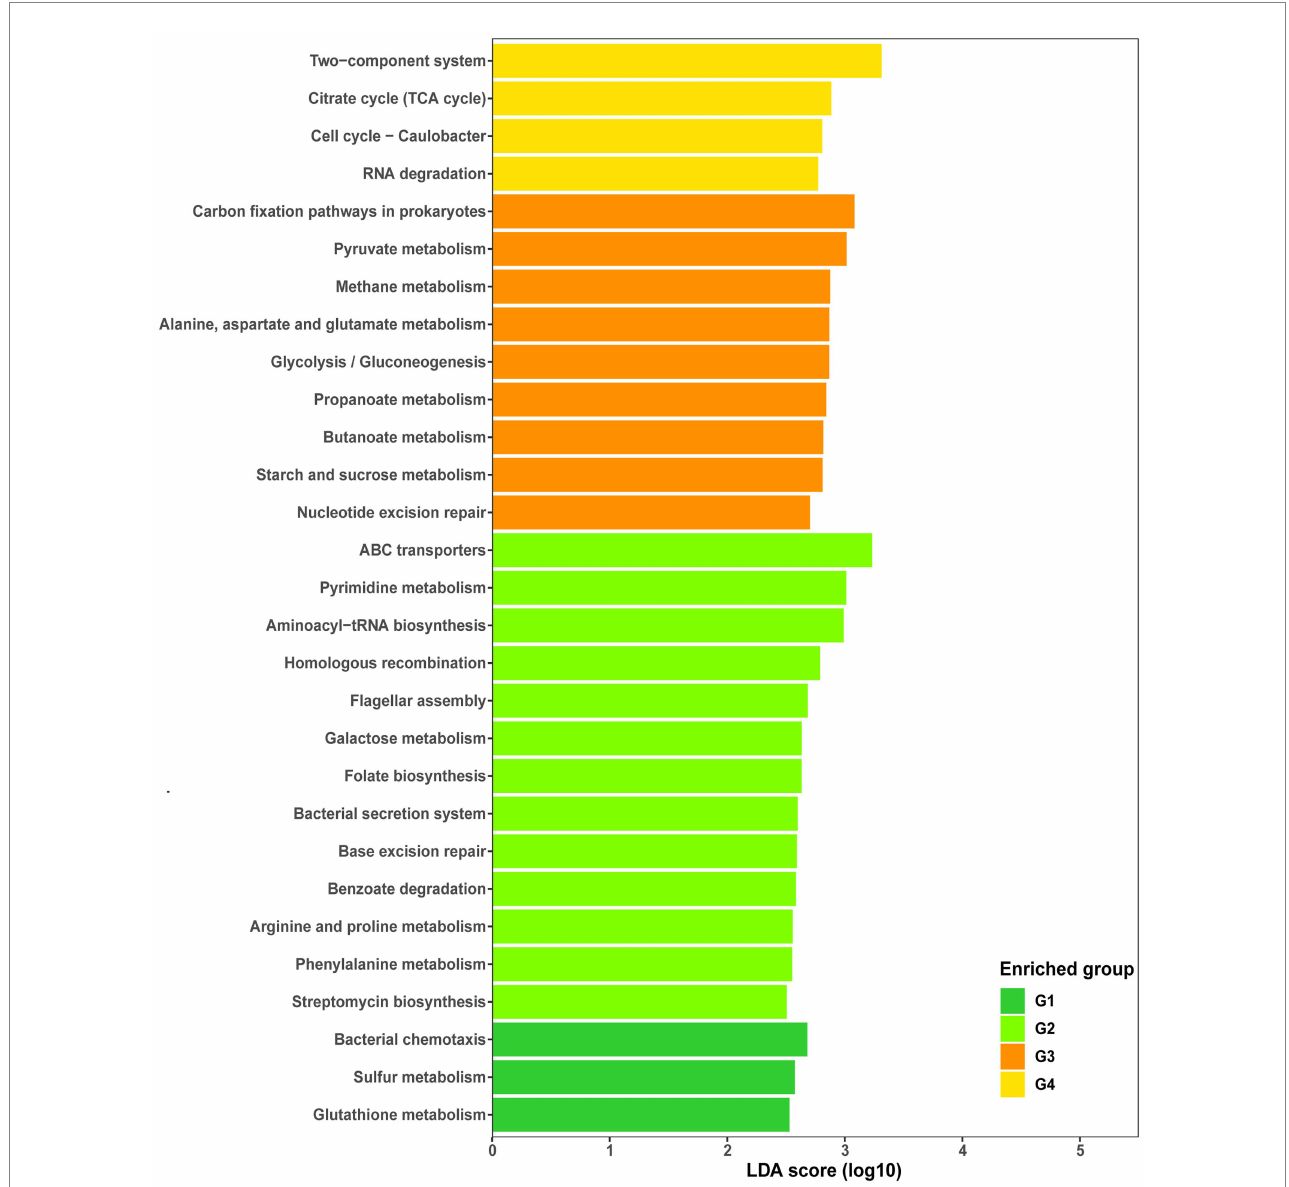
FIGURE 5 Histogram of linear discriminant analysis (LDA) of functional abundance in different groups using KEGG pathways. Significance was determined by LDA effect size (LEfSe) at p < 0.05 (Kruskal–Wallis test) and LDA score > 2.5. G1, 101-14 treated with NaCl; G2, 101-14 treated with ddH 2 O; G3, 5BB treated with NaCl; G4, 5BB treated with ddH 2